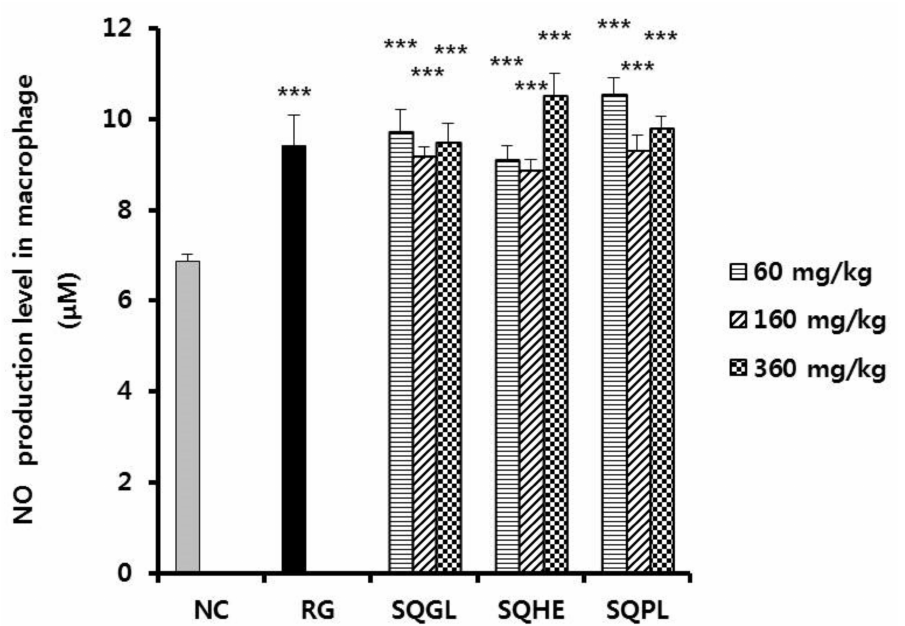
Figure 4. Nitric oxide production in peritoneal macrophage in the mice administered S. quelpaertensis leaves fermentation products for two weeks. NC, negative control; RG, red ginseng (100 mg/kg); SQGL, S. quelpaertensis leaves fermentation product by G. lucidum ; SQHE, S. quelpaertensis leaves fermentation product by H. erinaceum ; SQPL, S. quelpaertensis leaves fermentation product by P. linteus . *** p <